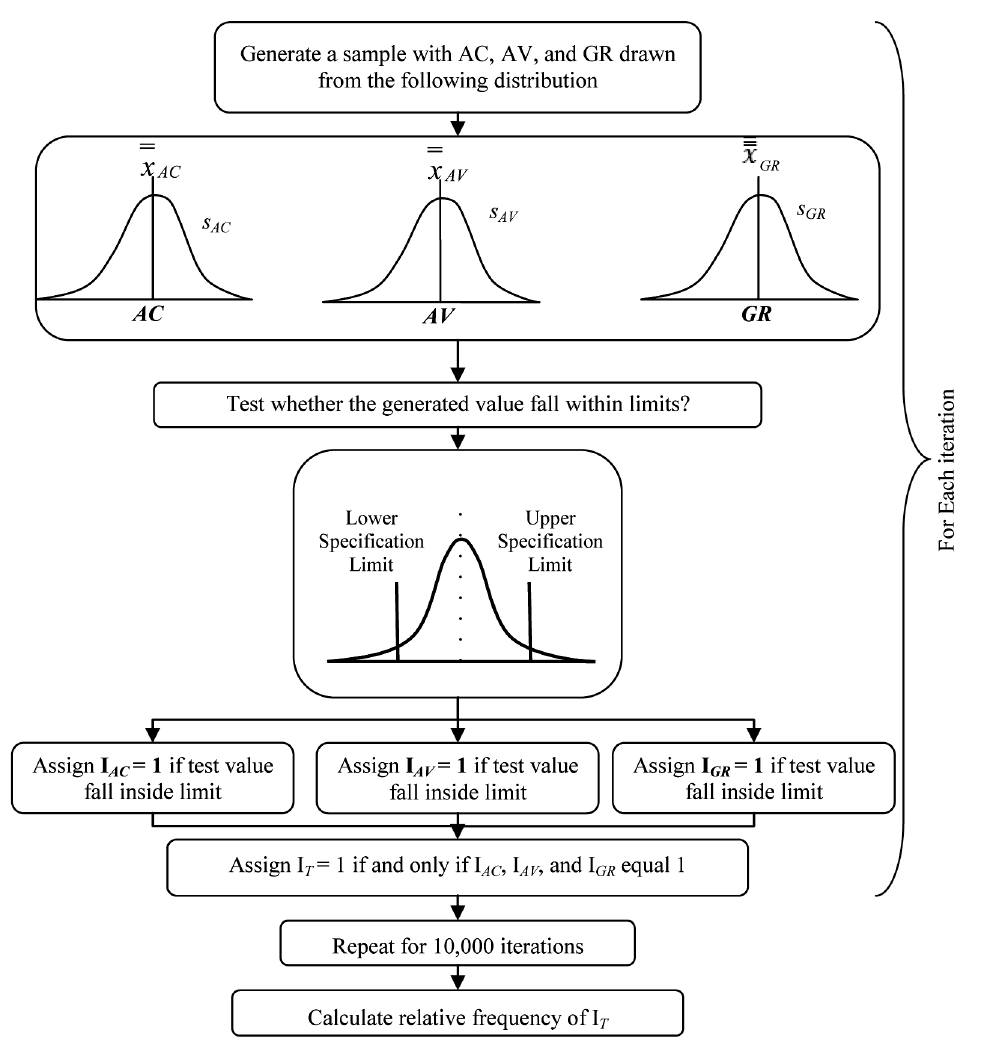
Fig. 2. PD T simulation